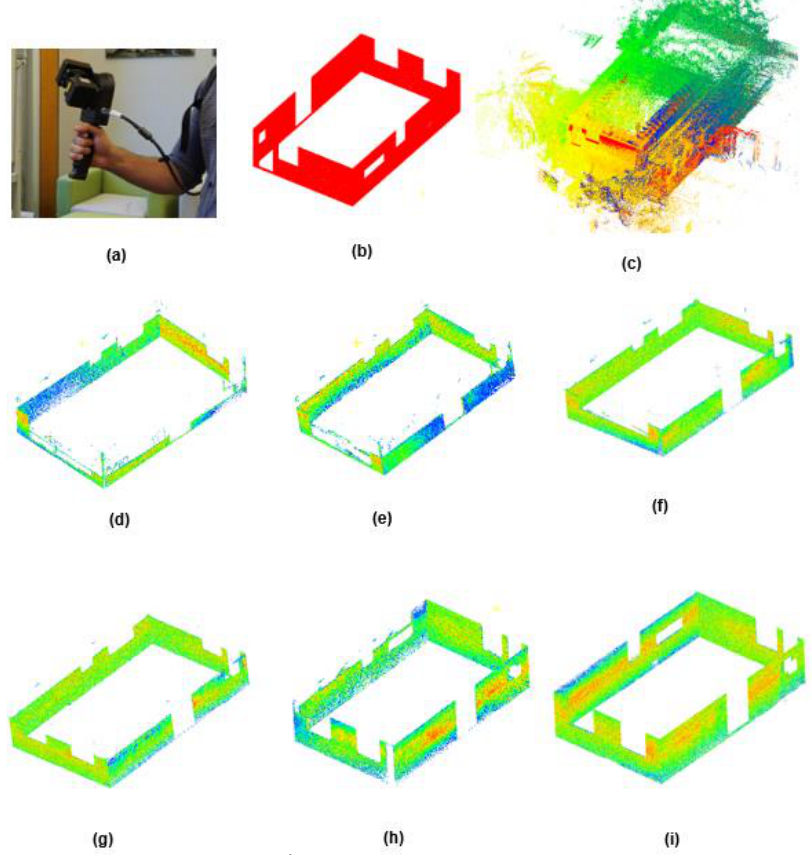
Figure 3. Site scan and filtration result: ( a ) Geo-SLAM ZEB-Revo scanner; ( b ) benchmarking point cloud for exterior surfaces of walls; ( c ) registration of site scan and benchmarking point cloud; ( d ) result of filtration, first scan; ( e ) result of filtration, second scan; ( f ) result of filtration, third scan; ( g ) result of filtration, fourth scan; ( h ) result of filtration, fifth scan; ( i ) result of filtration, sixth scan.